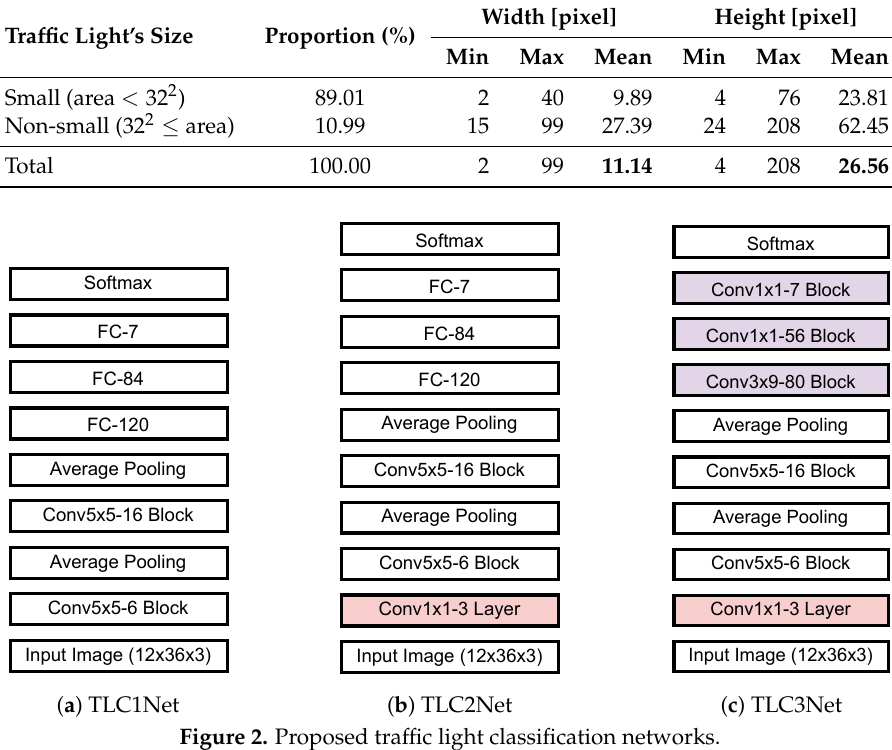
Table 1. Analysis of traffic light size in evaluation dataset.